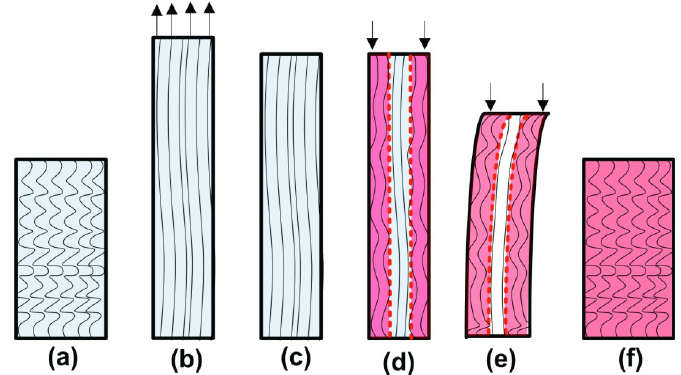
Figure 12. Illustration of underlying mechanism. ( a ) Original amorphous PMMA; ( b ) uniaxial stretching at high temperatures; ( c ) cooling and unloading; ( d ) ethanol penetrating and outer layer softening; ( e ) buckling at a critical penetration depth; and ( f ) final shape after recovery. Area in red is with ethanol. (Reproduced with permission from [105]. Copyright 2011 American Institute of Physics).